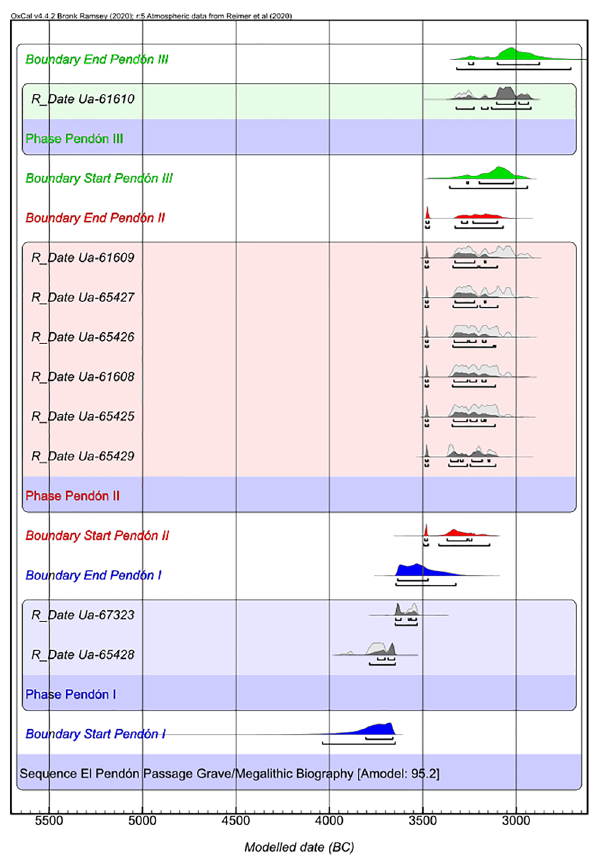
Figure 2. Bayesian model ( Phase sequential analysis ) of 14C dates from the Dolmen of El Pendón (ash grey curve = calibrated dates; dark grey = modelled dates). The estimated start and end boundaries are presented for each phase of megalithic activity. Please refer to Supplementary Text S2 for the agreement indices and other data about the chronometric